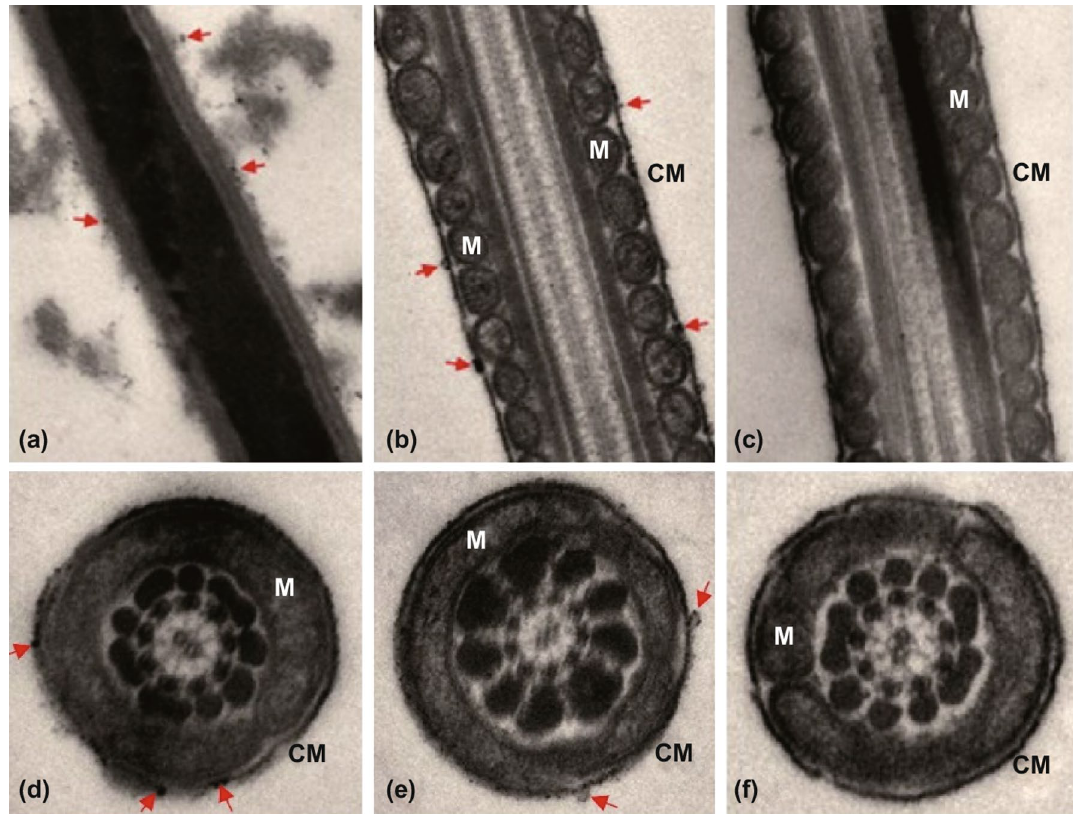
Fig. 8 TEM images of spermatozoa samples treated with carboxylated C 60 at 4 °C. The spermatozoa were collected after 15 days of treatment. TEM images showing a the sperm head interacting with carboxylated C 60 (2 μg mL −1 ), b the sperm midpiece interacting with carboxylated C 60 (2 μg mL −1 ), c the sperm midpiece without carboxylated C 60 . d , e Cross-sectional TEM images showing the sperm midpiece interacting with carboxylated C 60 (2 μg mL −1 ). f Cross-sectional TEM image showing the sperm midpiece without carboxylated C 60 . CM: cell membrane; M: